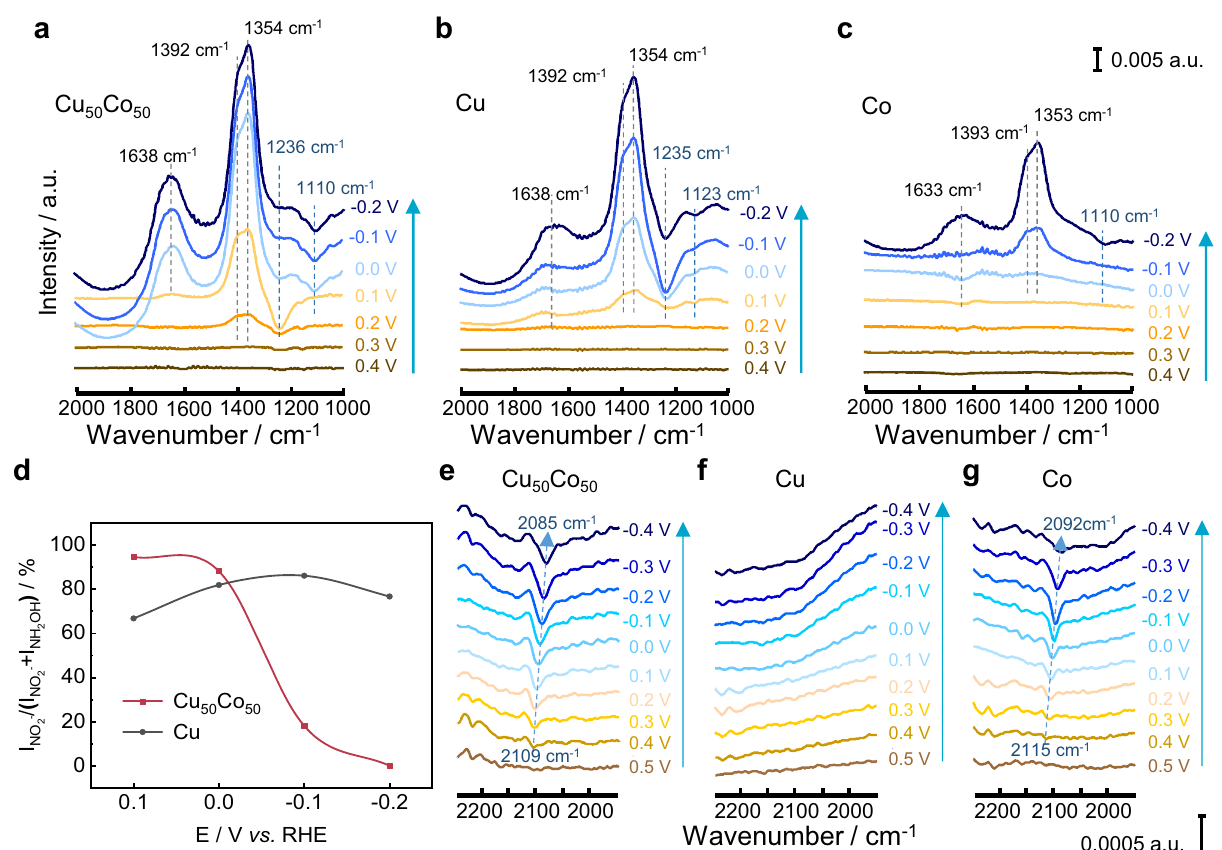
Fig. 4 | Electrochemical in situ FTIR spectra. Electrochemical thin-layer in situ FTIR spectra of NO 3 − RR on Cu 50 Co 50 ( a ), Cu ( b ), and Co ( c ) in 100mM KNO 3 +1M